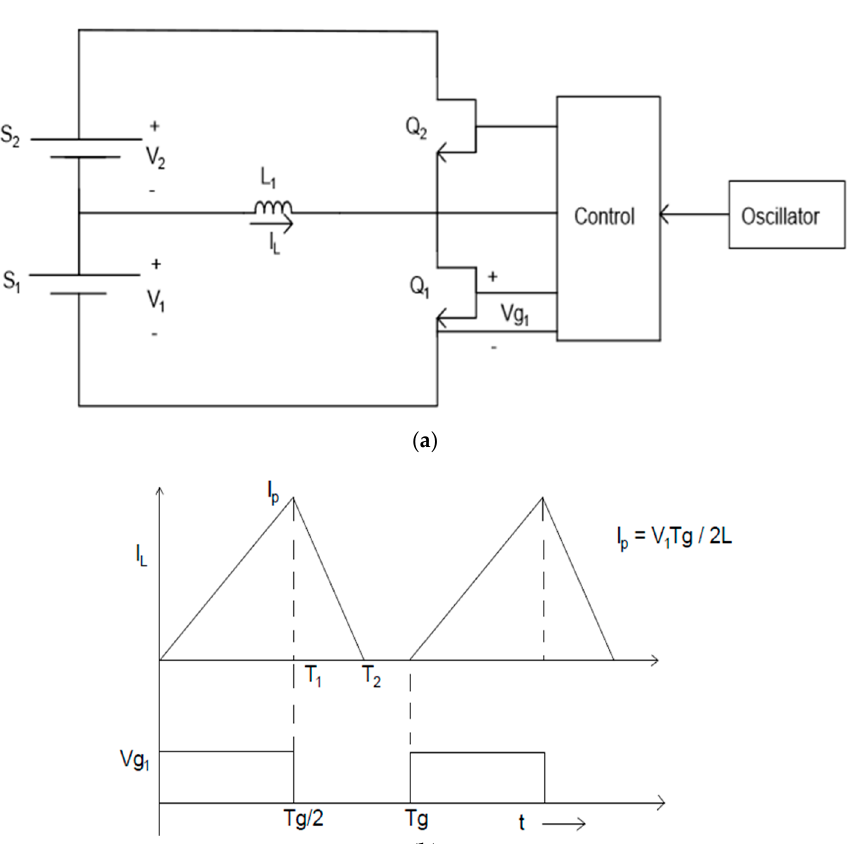
Figure 3. Basic inductive AEQ driver and waveforms. ( a ) Inductive AEQ driver connected to battery sections S 1 and S 2 . ( b ) Inductor current, I L , and Q 1 gate drive waveforms.